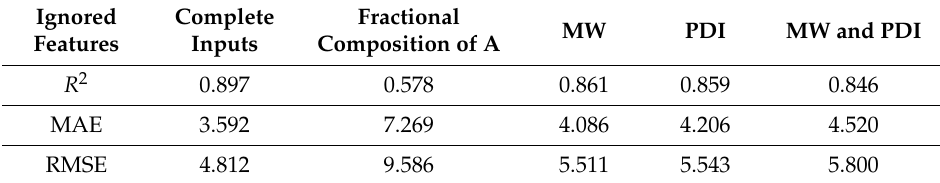
Figure 8. The scatter plot of the predicted vs. experimental T g after di ff erent inputs were removed from the DNN model. ( a ) Fractional composition of A; ( b ) molecular weight; ( c ) polydispersity index (PDI); ( d ) both molecular weight and PDI. Table 3. The R 2 , MAE, and RMSE with di ff erent ignored